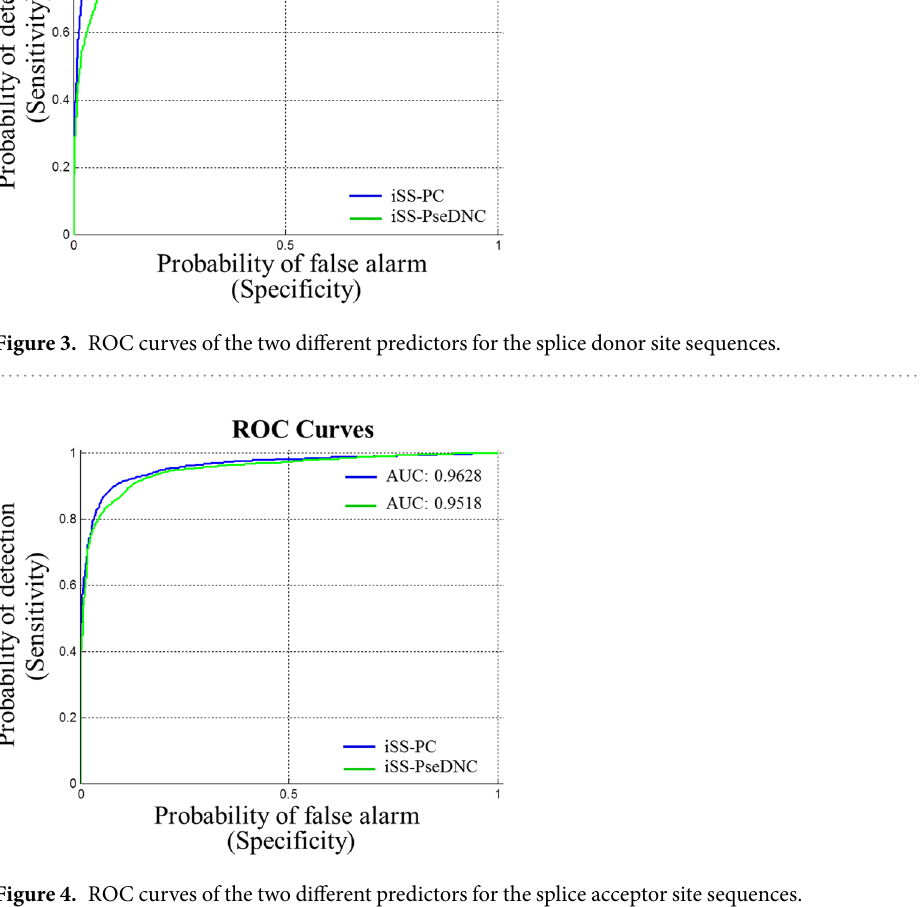
Figure 4. ROC curves of the two different predictors for the splice acceptor site